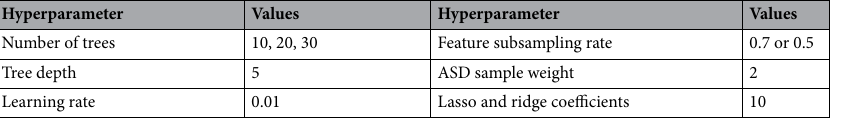
Table 4. Hyperparameters of the XGBoost classifier. The feature subsampling rate is set to 0.7 and 0.5 for semi-automatic and automatic feature selection strategies